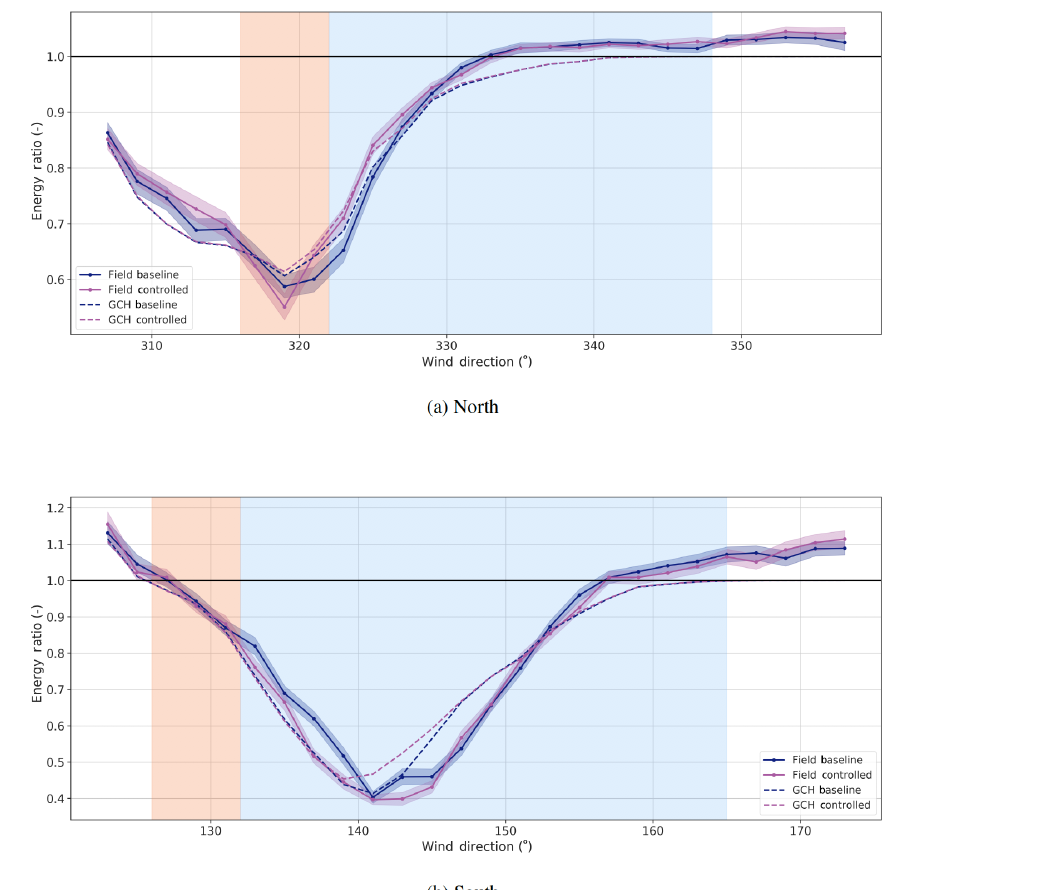
Figure 12. Energy ratios of the third turbine in the row for the North Campaign (T4) and the South Campaign (T2). The effect of secondary steering is helpful on the right side of the nadir and harmful otherwise. The mismatch in the baseline nadir of the South Campaign suggests directional calibration issues.